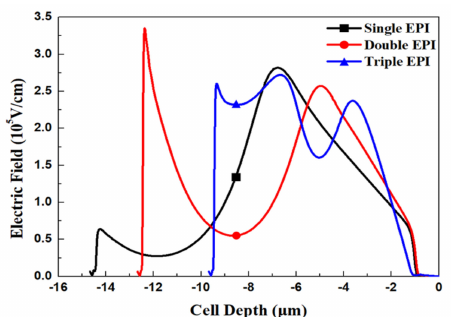
Figure 10. The simulated electric field curves for the split-gate trench power MOSFET with single EPI, double EPIs, and triple EPIs at 150 V rating voltage.